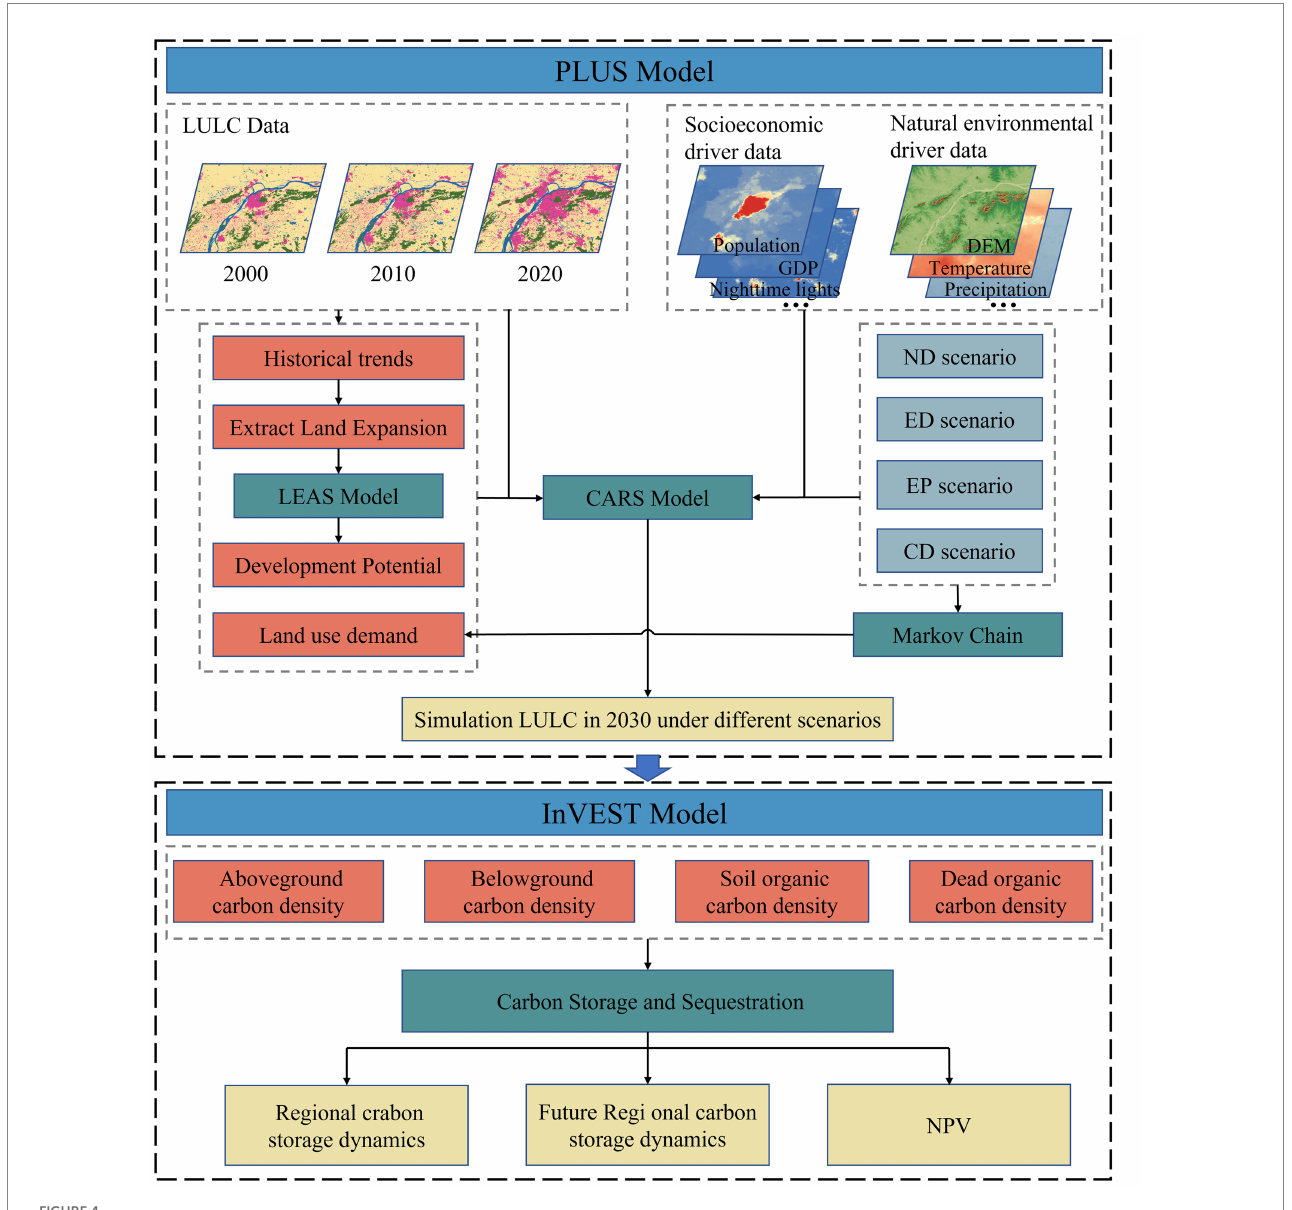
FIGURE 4 Research